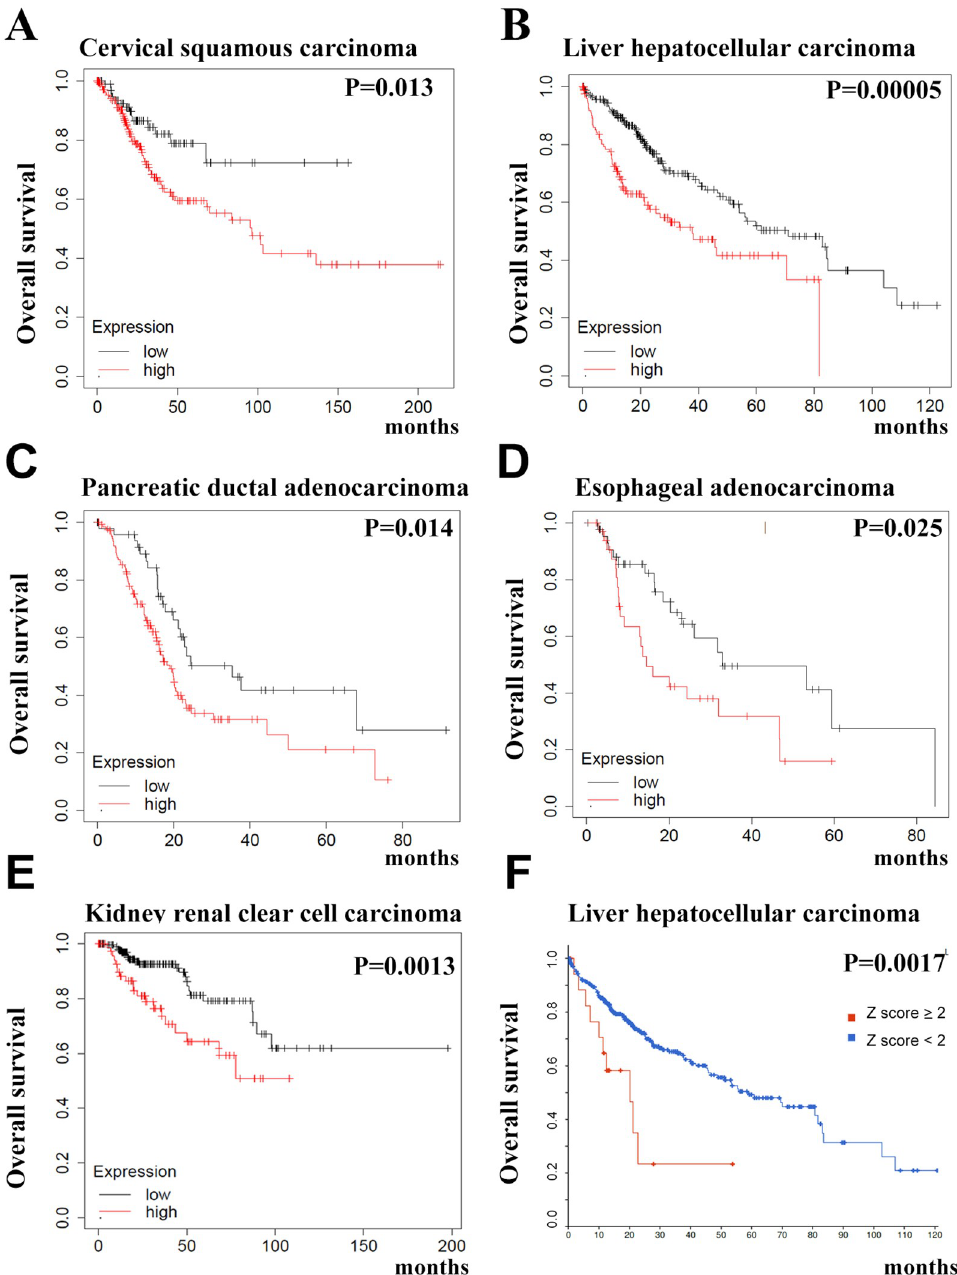
Fig 1. PUF-A expression level is associated with the overall survival of cancer patients. (A) Cervical squamous carcinoma. n = 304. (B) Liver hepatocellular carcinoma. n = 371. (C) Pancreatic ductal adenocarcinoma. n = 177. (D) Esophageal adenocarcinoma. n = 80. (E) Kidney renal papillary cell carcinoma. n = 288. The cohorts were divided into two groups, high (red) and low (black), according to the median expression value of PUF-A , which were retrieved from the Kaplan–Meier plotter database (http://kmplot.com/analysis/index.php?p=service&cancer). (F) Liver hepatocellular carcinoma. n = 365. Patient data was obtained from cBioPortal TCGA PanCancer Atlas dataset. Z score � 2 (red).